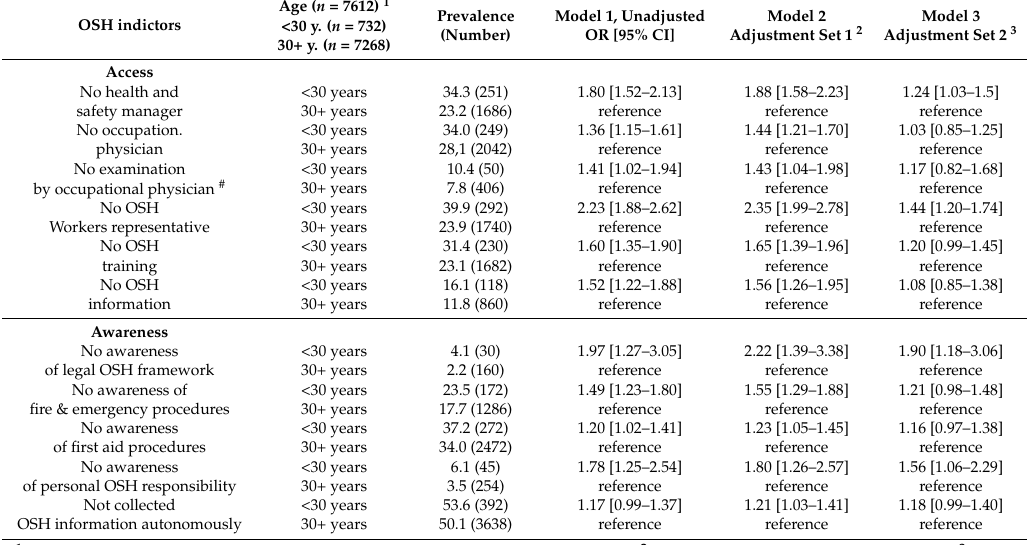
Table 2. Occupational safety and health (OSH) service access and awareness by age groups; prevalence rates (numbers) and results from logistic regression analyses (odds ratios (OR) [95% confidence interval]).